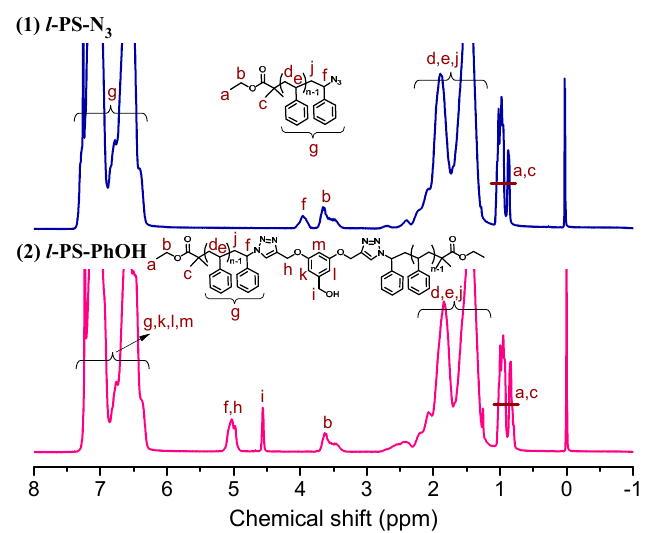
Figure 1. 1 H NMR (300 MHz) spectra of l -PS-N 3 and l -PS-PhOH in CDCl 3 .